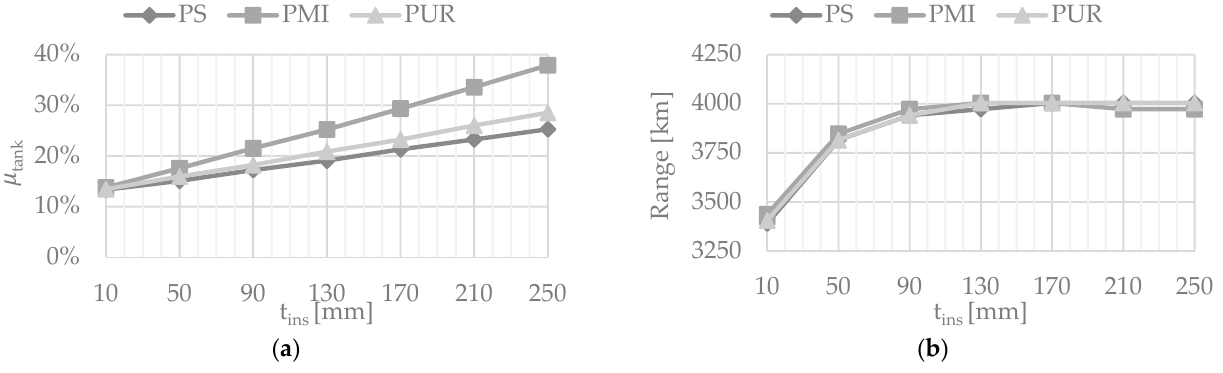
Figure 17. Influence of insulant material selection and layer thickness ( t ins ) on empty mass fraction µ tank ( a ) and range flown ( b ), assuming the same internal volume available for LH 2